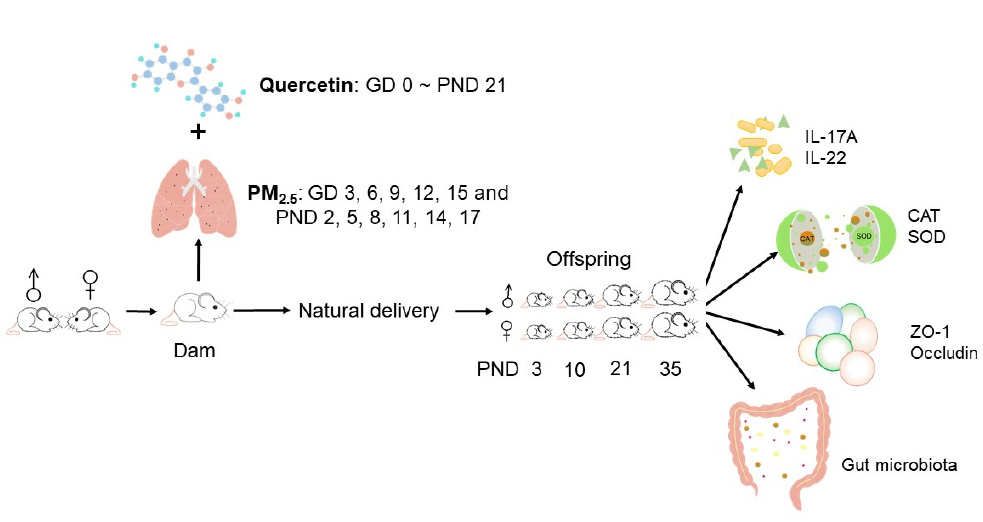
Figure 1. Experimental study design. A pair of male and female cubs born to the same mother were sacrificed on PND 3, 10, 21, and 35. Colonic microbiota, inflammatory biomarkers, antioxidases, and related proteins were detected. GD: gestational day; PND: postnatal day; IL: interleukin; CAT: